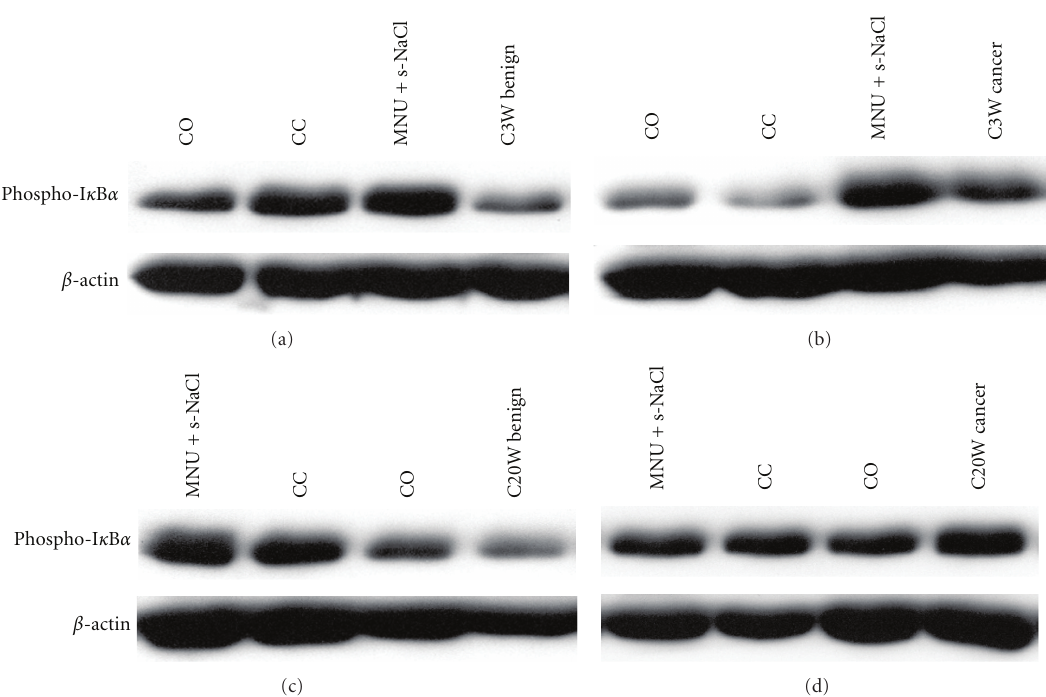
Figure 2: Western blot analysis of phospho-I κ B α expression. Curcumin supplementation in C3W benign group declined the expression of phosphorylated I κ B α compared with MNU + s-NaCl (a), whereas the expression of phosphorylated I κ B α in C3W cancer group did not decrease (b). Curcumin supplementation for 20 weeks in C20W benign decreased the expression of phosphorylated I κ B α compared with MNU + s-NaCl (c), whereas the expression of phosphorylated I κ B α in C20W cancer group did not decline (d). An antibody for β -actin was used as an internal